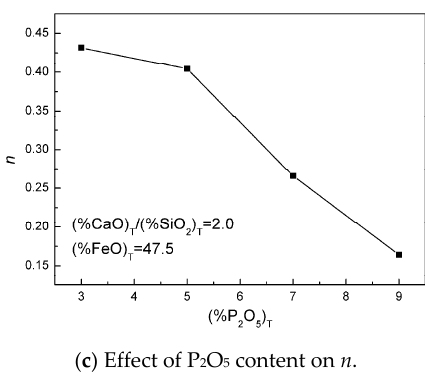
Figure 12. Effect of the slag compositions on n.